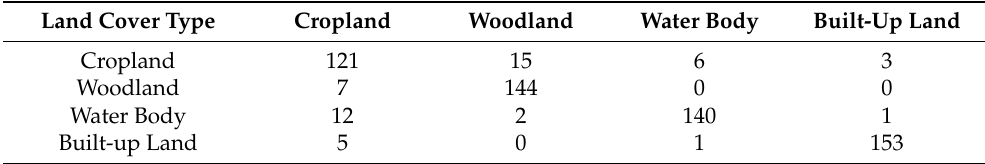
Table 4. Confusion matrix of validations (round to integers) for land use/land cover data sets over the past 21 years.